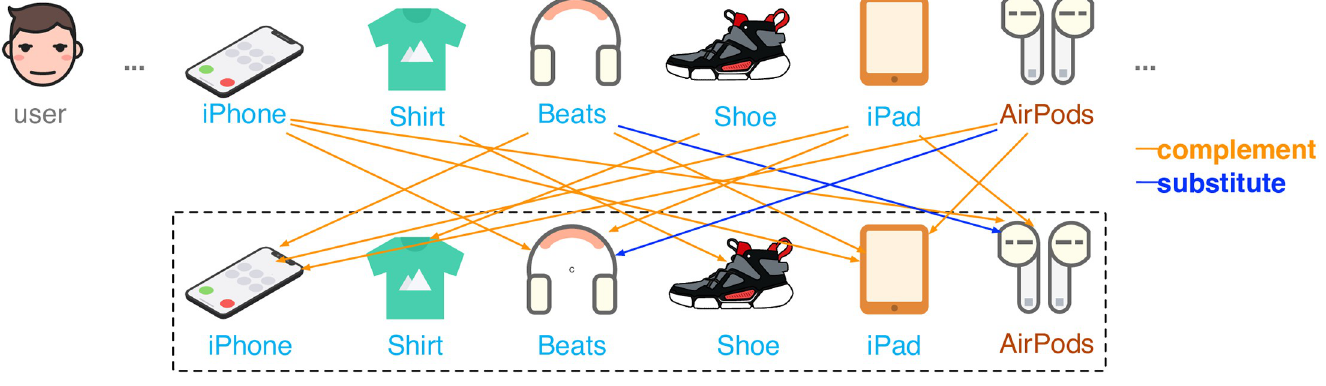
Fig 1. An example of user’s purchasing sequence with item